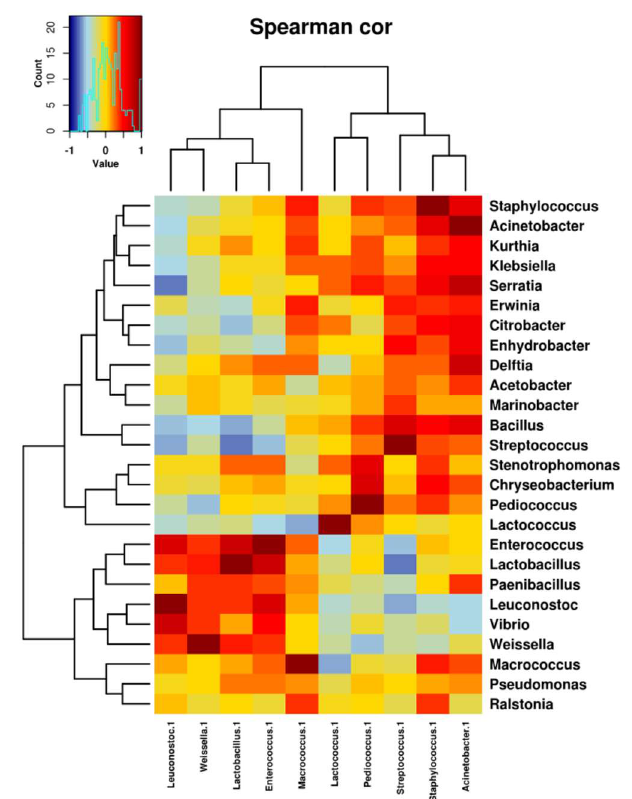
Figure 6. Co-occurrence and co-exclusion relationships between genera observed in cheeses, based on Spearman’s correlation. Only OTUs with a frequency greater than 0.5% in at least one sample are shown. The color of the scale bar indicates the type of correlation, with +1 indicating a positive correlation (dark red) and -1 indicating a negative correlation (dark blue).